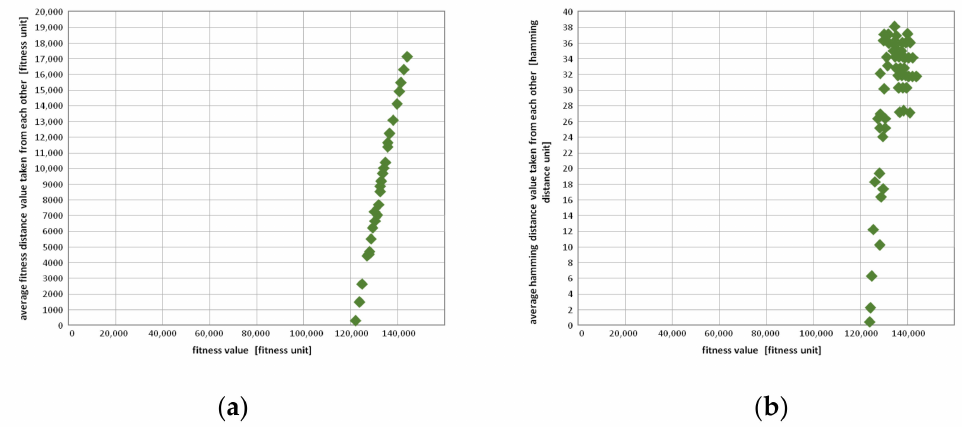
Figure 10. The fitness values and their fitness distances ( a ) and hamming distances ( b ) from the best of the solutions in case of 2-opt